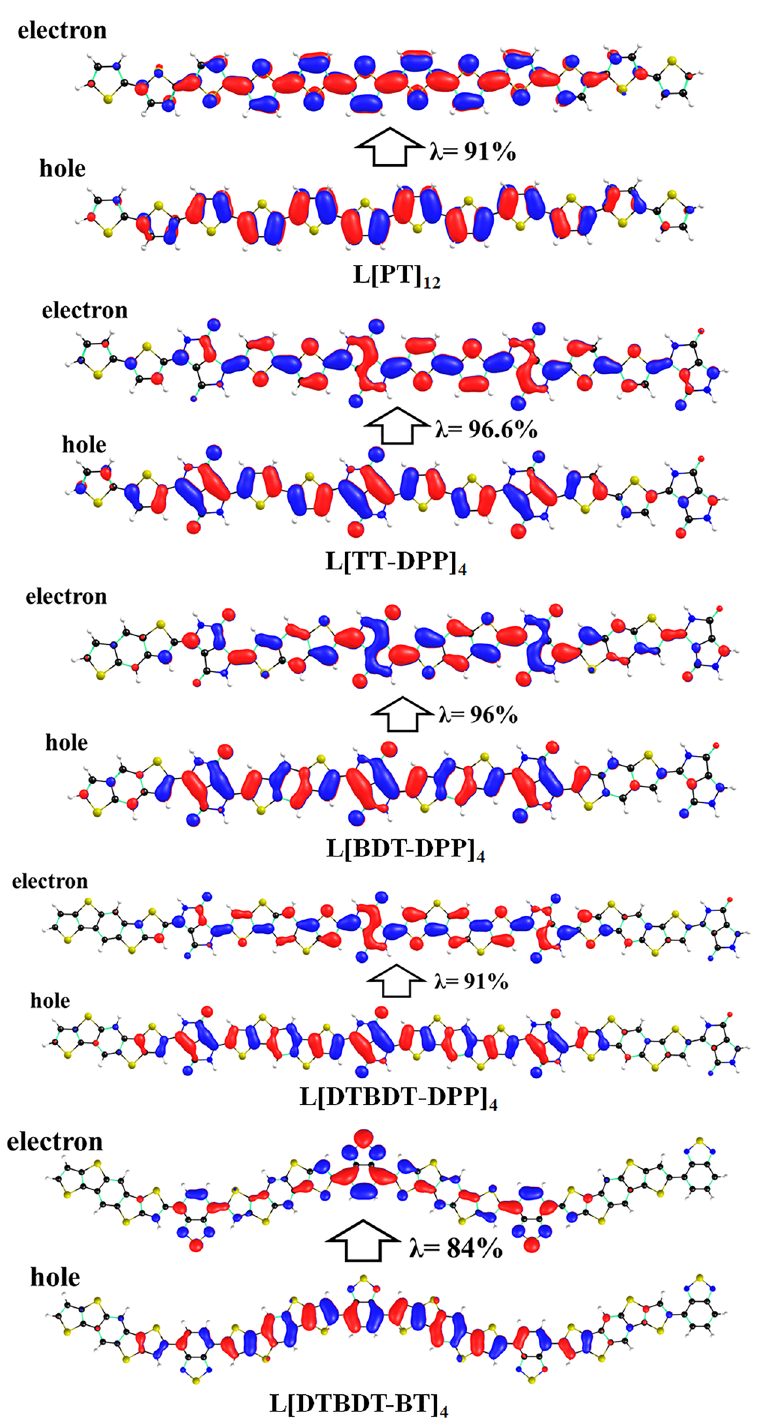
Figure 8. Pictorial representation of the natural transition orbitals of linear (L[PT] 12 , L[TT-DPP] 4 , L[BDT- DPP] 4 , L[DTBDT-DPP] 4 , and L[DTBDT-BT] 4 ) molecules corresponds to their lowest excited states (S 1 ) calculated at TD-mPW1PW91/6-31G(d,p) level of theory. Where, λ is the fraction of the hole–electron contribution to the